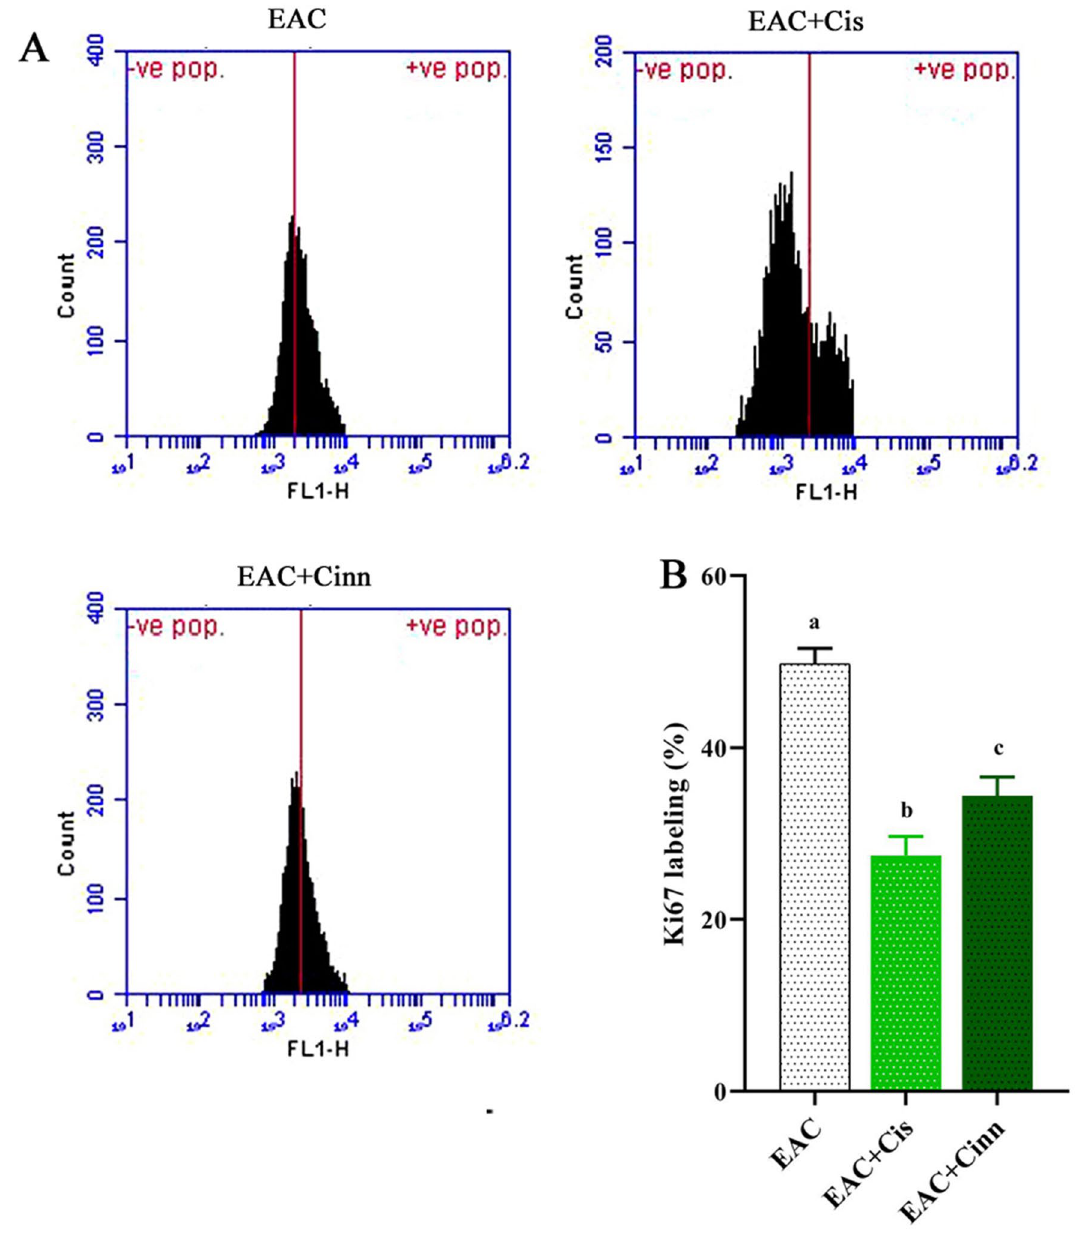
Figure 9. The effect of cinnamon essential oil (Cinn, 50 mg/kg b.wt/day, orally) after 12 days of the treatment on the proliferative capability of Ehrlich ascites carcinoma (EAC) cells using the flow cytometric analysis of Ki67 nuclear proliferation marker ( A ). Cinn essentil oil control tumor cells’ growth by reducing expression levels of the nuclear protein Ki67. Statistical data were shown as (Mean ± SD), n = 3, ( B ). Significant differences ( P < 0.05) between groups were shown by different letters. Cis, Cisplatin (2 mg/kg b.wt,